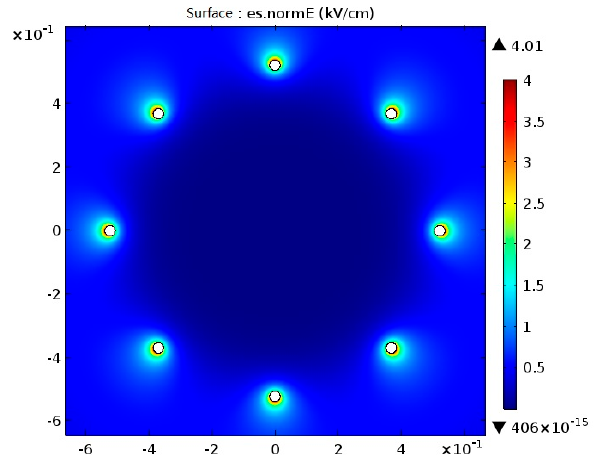
Figure 3. Contour surface of electric-field strength (kV/cm) of the 8 × LGJ630 bundle in the UHV corona cage. Table 2. Field strength of bundled conductors in the UHV corona cage.